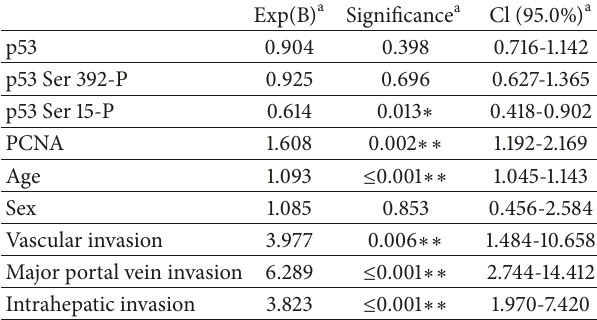
Table 5: Cox proportional hazard model analysis of p53, p53